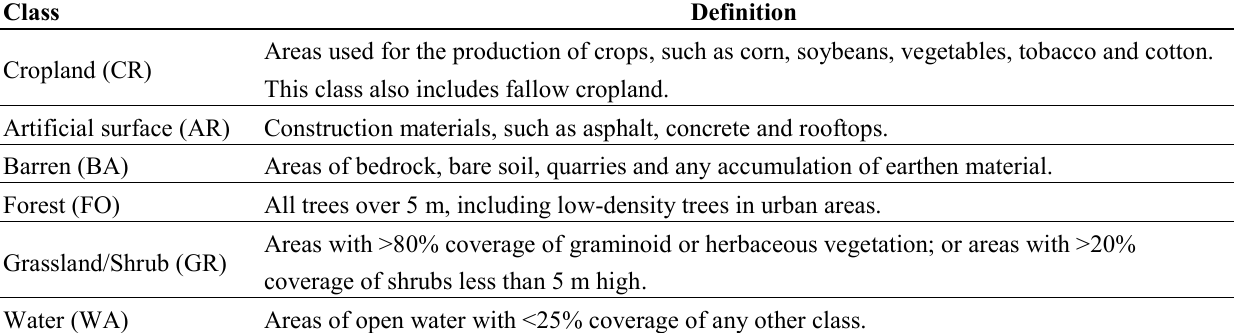
Table 1. Land cover classes adapted from the National Land Cover Database 2006 (NLCD